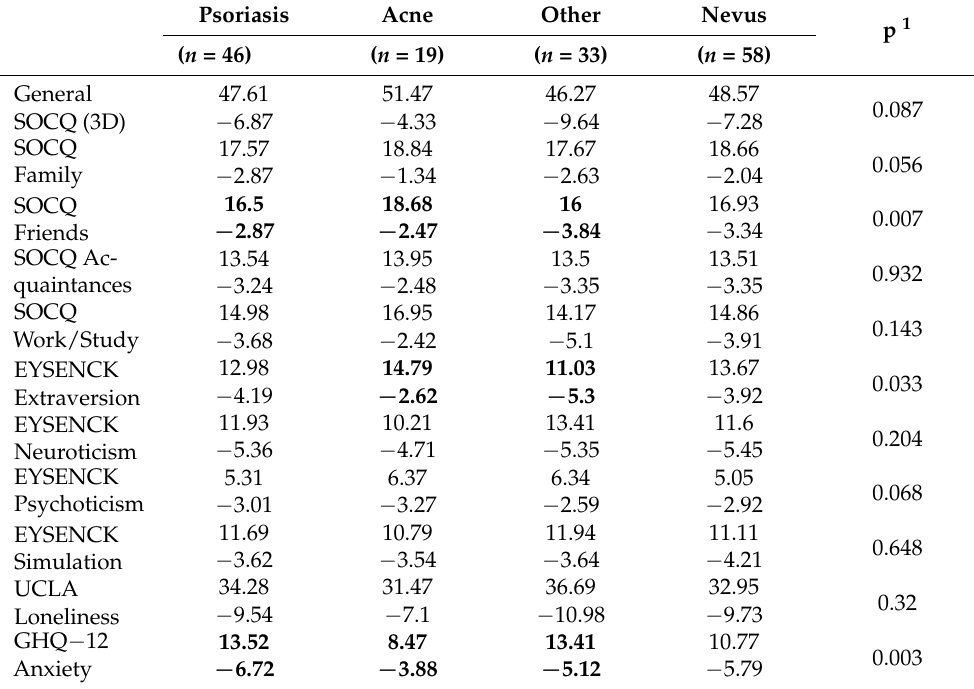
Table 3. Comparison of results according to skin diseases.